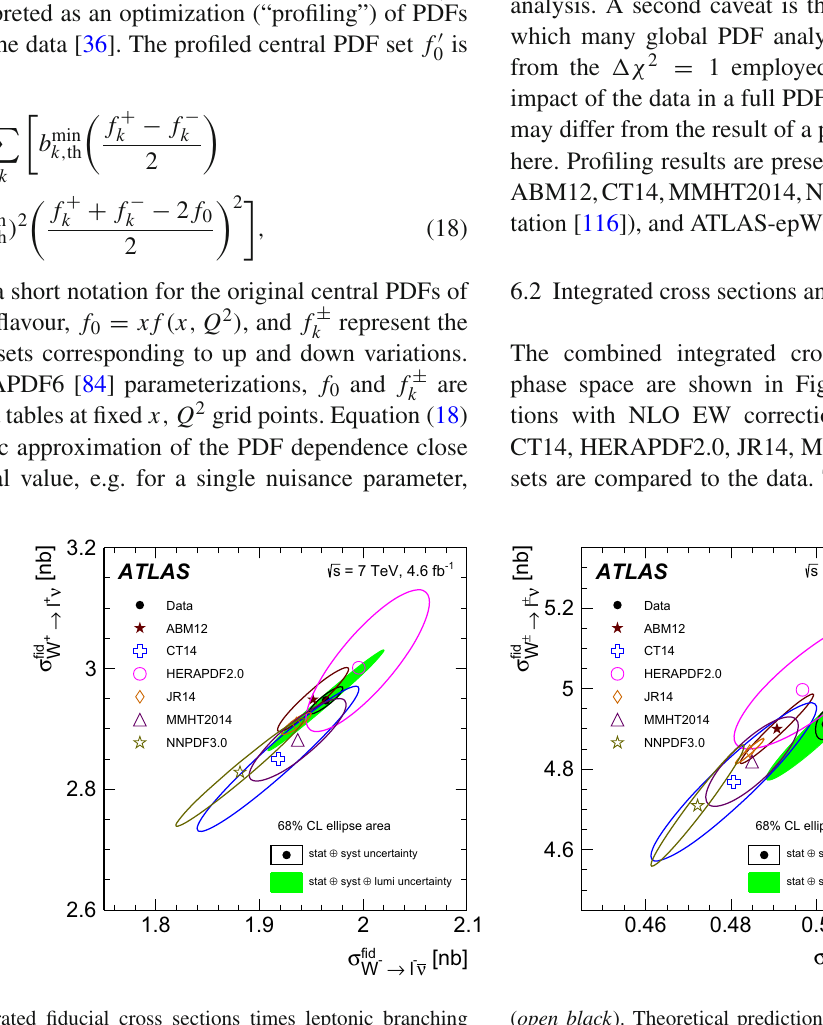
Fig. 19 Integrated fiducial cross sections times leptonic branching ( open black ). Theoretical predictions based on various PDF sets are ratios of σ fid vs. σ fid ( left ) and σ fid vs. σ fid shown with open symbols of different colours . The uncertainties of the W + → (cid:3) + ν W − → (cid:3) − ¯ ν W ± → (cid:3) ± ν Z /γ ∗ → (cid:3) + (cid:3) − theoretical calculations correspond to the PDF uncertainties ( right ). The data ellipses illustrate the 68% CL coverage for the total uncertainties ( full green ) and total excluding the luminosity uncertainty